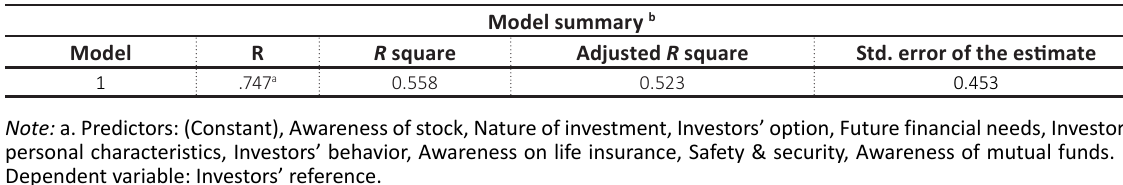
Table 8. Regression model